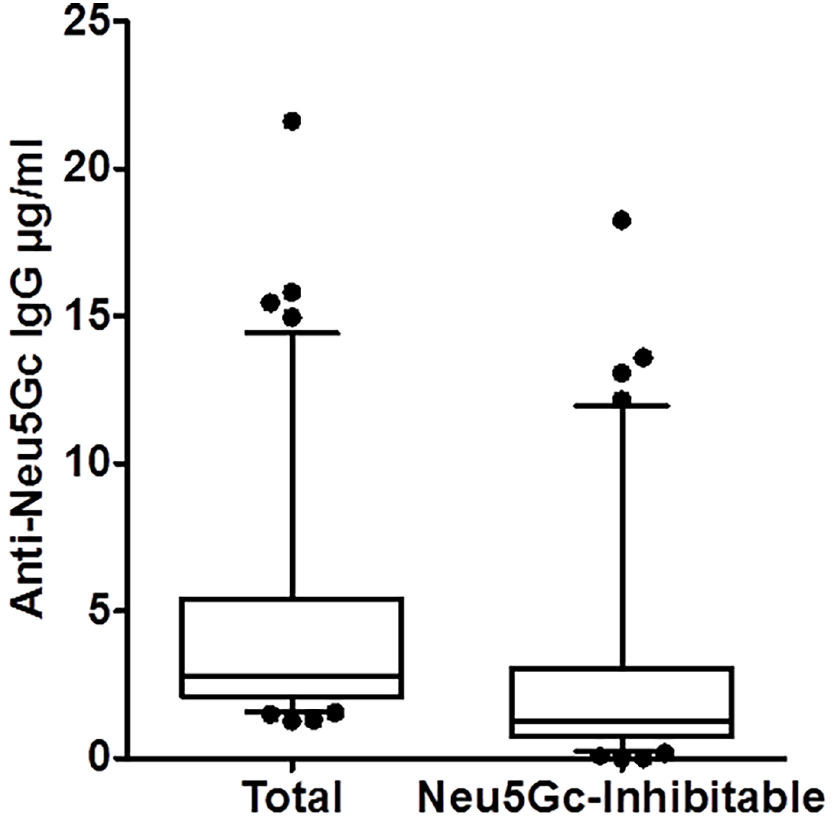
Fig 3. Distribution of anti-Neu5Gc IgG titers against a mixture of epitopes in NHS II population. Plasma total and inhibitable anti-Neu5Gc IgG levels were quantified by ELISA using wild-type mouse serum as a target that contains naturally occurring Neu5Gc containing sialoglycoproteins epitopes as antigens (N = 46; Table 1). Total anti-Neu5Gc IgG refers to the “raw” antibody level obtained against the ELISA target. To obtain a more specific titer, plasma was incubated with free Neu5Gc α 2Me to block non-specific binding and the inhibitable anti-Neu5Gc IgG is this signal subtracted from the total signal. Plasma anti-Neu5Gc IgG antibodies in the NHS II population displayed a discontinuous distribution. While the majority of individuals have low levels, a minority of samples (represented by dots) exhibit very high levels of anti-Neu5Gc IgG.